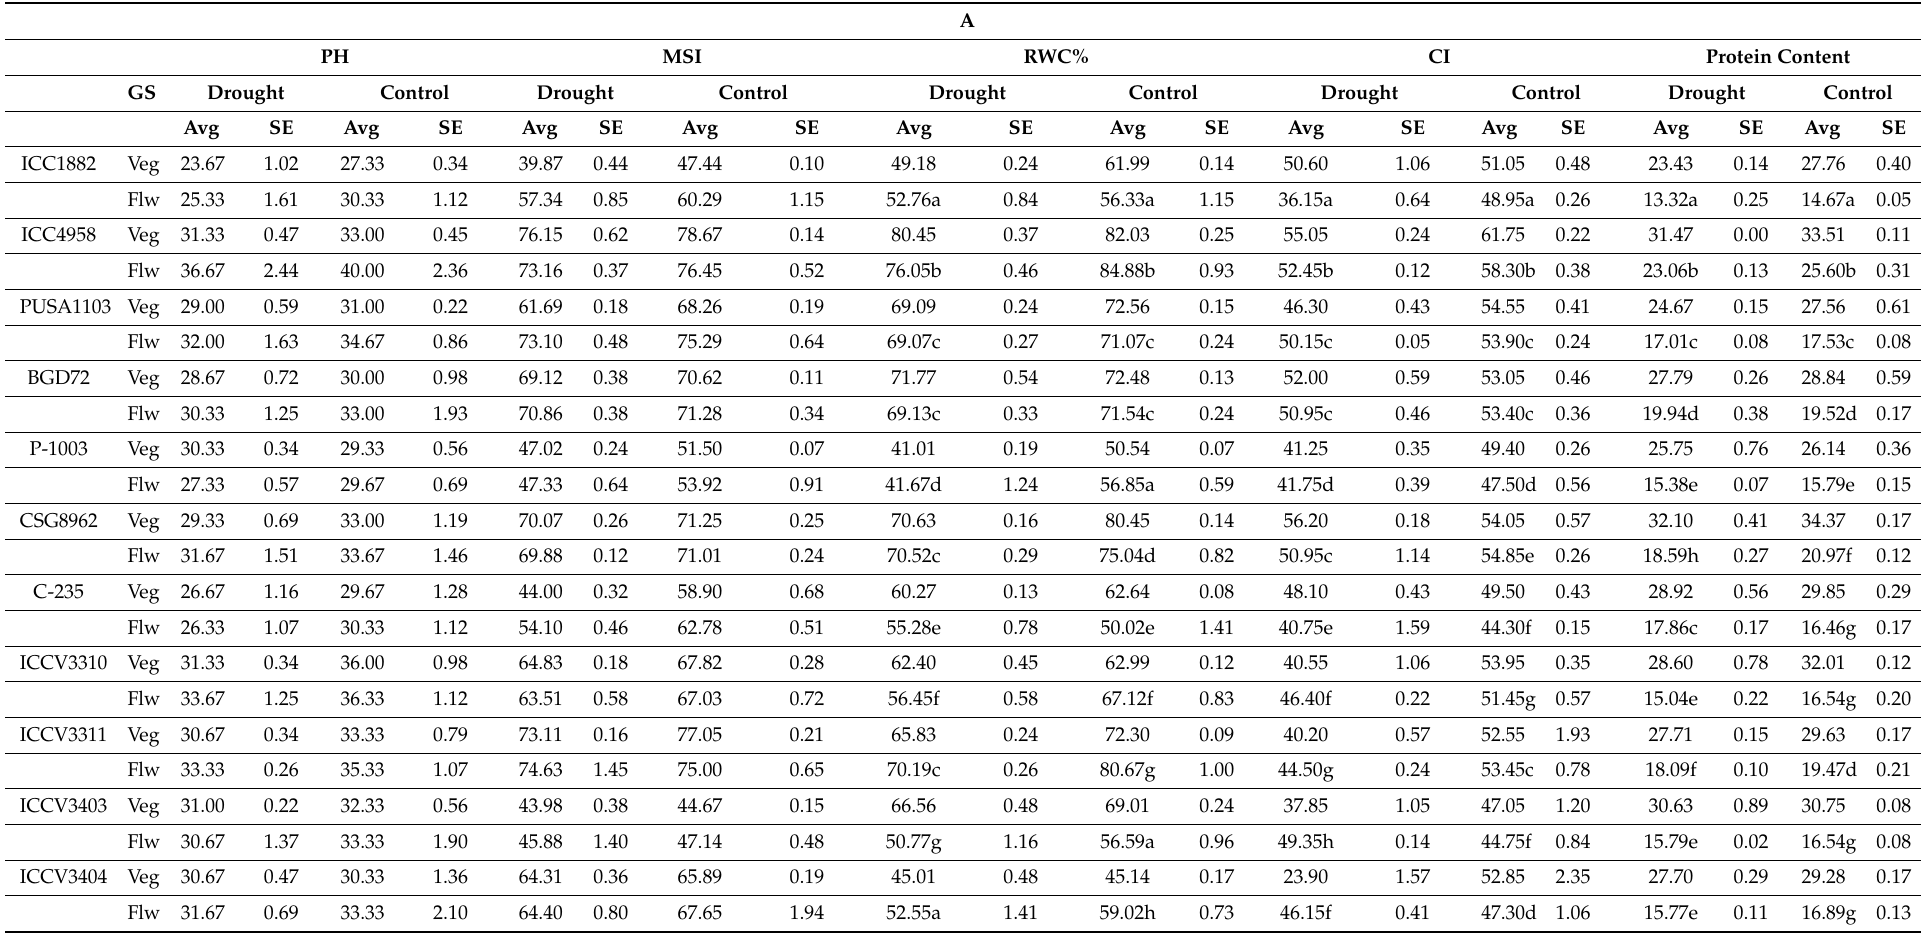
Table 3. A: Means [ ± standard error (SE)] of plant height, membrane stability index, relative water content, chlorophyll index and protein content (leaf) at vegetative and reproductive stages under irrigated and stressed conditions. B: Means [ ± standard error (SE)] of days to flowering, days to maturity and secondary branches at vegetative and reproductive stages under irrigated and stressed conditions. C: Mean values of Biomass, 100seed weight (100SW), Filled pods per plant (FPP), Seeds per pod (SPP) and Plant yield (PY) of chickpea genotypes at reproductive